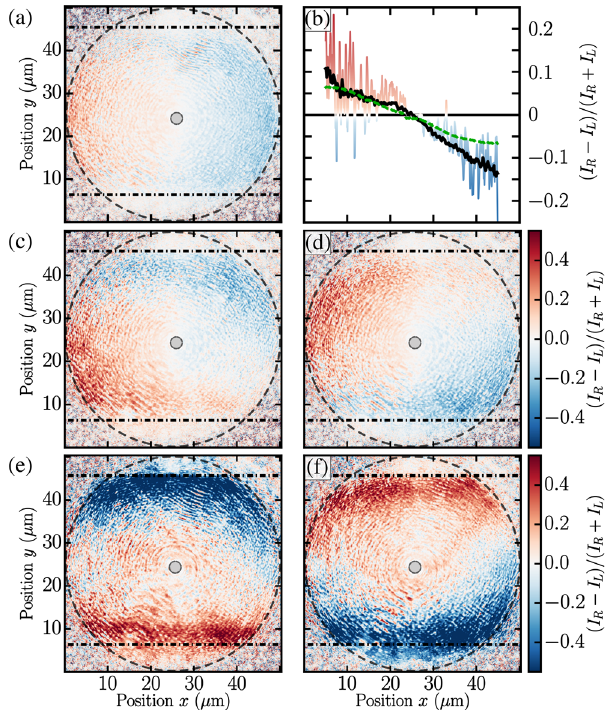
FIG. 3. Polariton acceleration in external electric and magnetic fields. (a) Normalized difference between two RF images of polariton flow in opposing electron density gradients. (b) Com- parison with a trajectory-based model (dashed green line). The red and blue line is a line cut of (a) at y ¼ 25 μ m and the black line is an average between y ¼ 10 and y ¼ 40 μ m. (c) – (f) Normalized difference between images I R , I L as in (a) for magnetic fields: (c) B ¼ 8 mT, (d) B ¼ − 8 mT (e), B ¼ 40 mT, and (f) B ¼ − 40 mT. The horizontal dash-dotted lines in (a),(c) – (f) delimit the width of the Hall bar, the large circle is the field of view of the microscope, and the central gray disk is the excitation